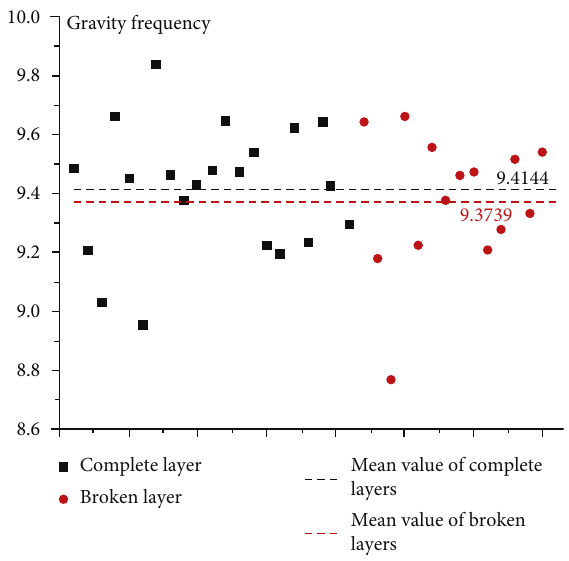
Figure 9: Gravity frequency scatter diagram.